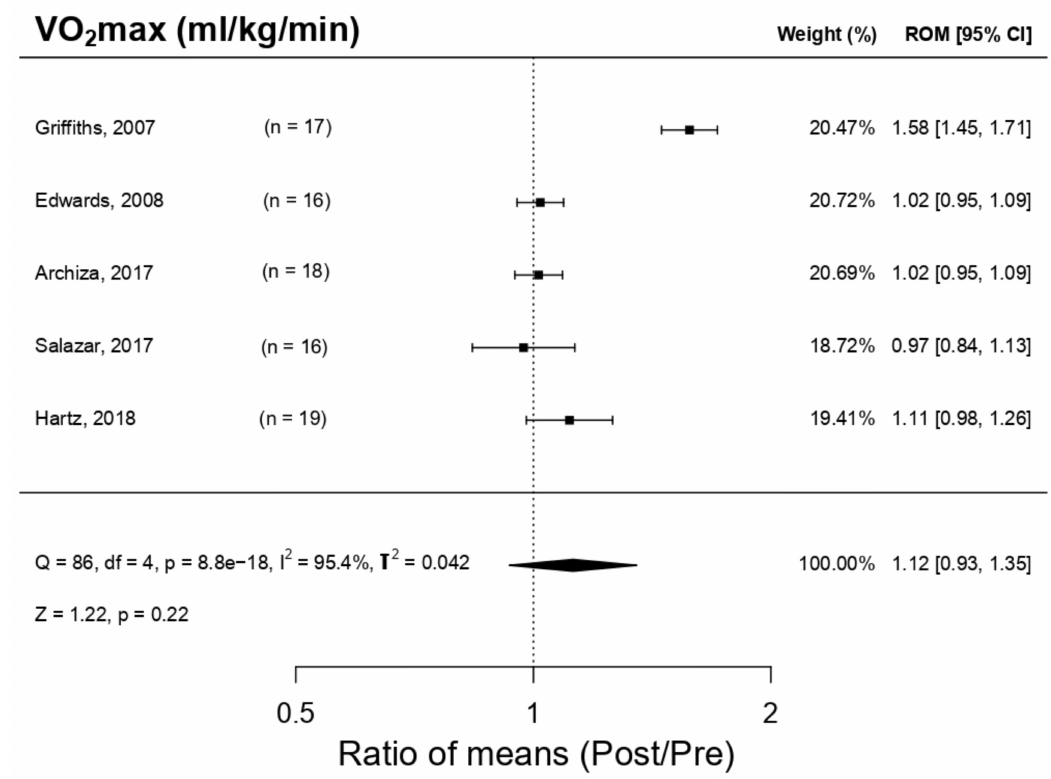
Figure 4. Forest plot of the meta-analysis of the effects of inspiratory muscle training with PowerBreath ® on Maximal oxygen volume. VO 2 max = Maximal oxygen volume; CI = Confidence Interval; ROM = Ratio of Means; Pre = Pre-inspiratory muscle training; Post = Post-inspiratory muscle training; Q = Cochran’s Q statistic; df: degrees of freedom; p = p -value (the first one refers to Cochran’s Q, the second one to Z); I 2 : I-square statistic; T 2 : Tau-squared; Z: